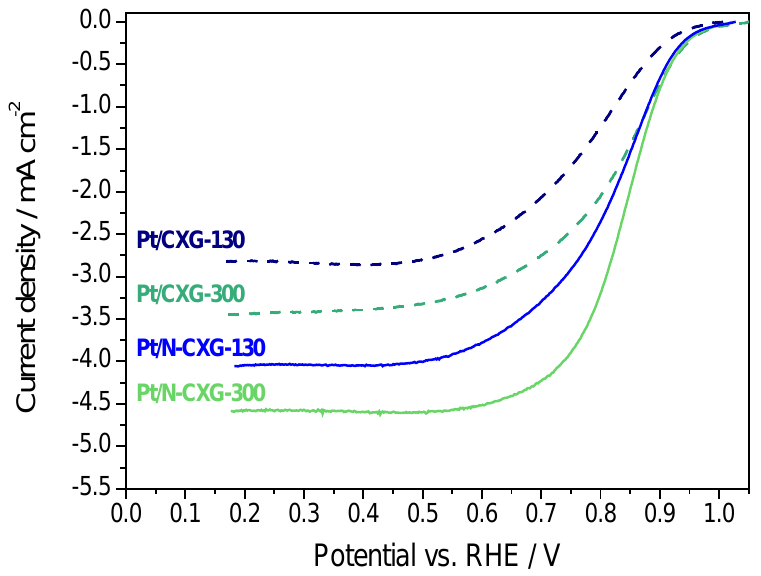
Figure 5. Linear sweep voltammetries obtained in a rotating disk electrode (RDE) in an O 2 -saturated 0.5 M H 2 SO 4 solution at ω = 1600 rpm; scan rate: 5 mV s −1 .